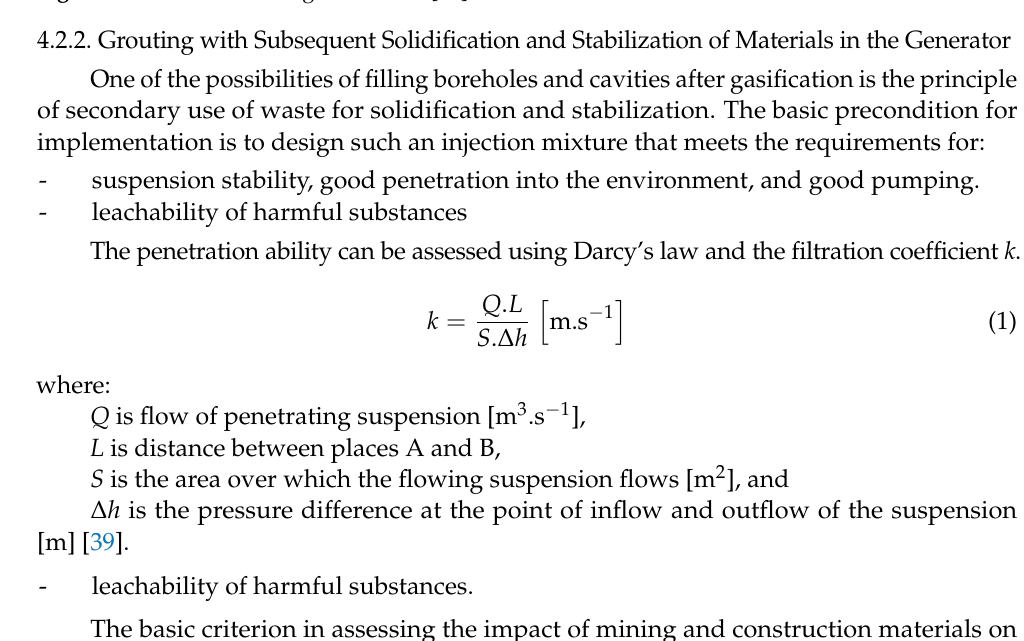
Figure 4. The boreholes of gassification [28].